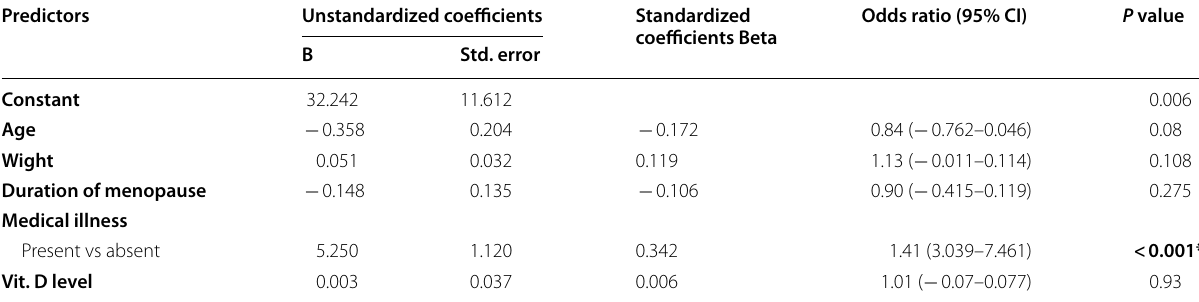
ANOVA < 0.001, R 2 * Statistical significance at P <